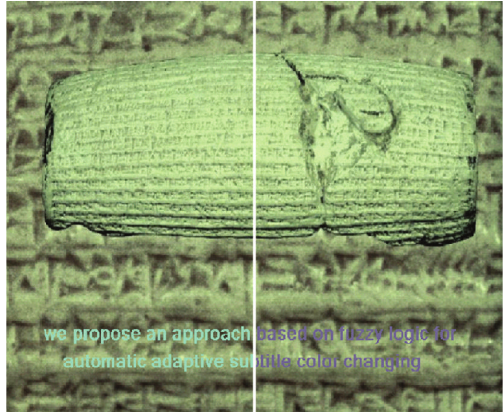
Figure 11: The image with the centroid values: R = 137, G = 146, and B = 111. (Cyrus Cylinder, The First Charter of Human Rights, 539 BCE).